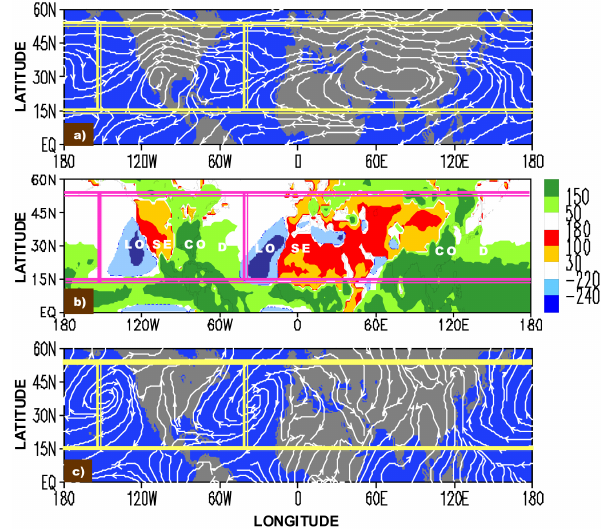
Fig. 7. Distributions of January mean quadruplet LOSECOD domi- nant heating ( b , unit is Wm − 2 ; adopted from Fig. 4b of Wu and Liu, 2003), and circulation at 200hPa (a) and 1000hPa (c) . Each grid along the subtropics has one continent in the center and is bounded by the longitudes at which the centers of sea-surface anticyclones are